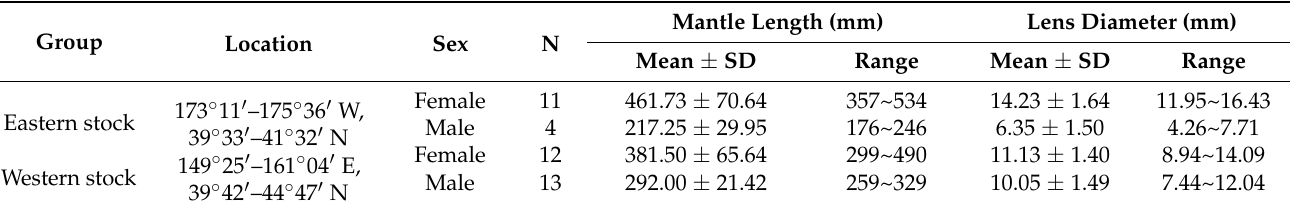
Table 1. Details of the O. bartramii